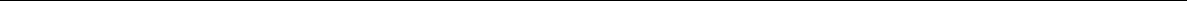
Fig. 2 IFT proteins are required for the timely relocalization of the kinase Aurora B to the central spindle. a Flag immunoprecipitation performed on mitotic HeLa Kyoto cells transfected with Flag and Myc or with Flag-IFT27 and Myc-Aurora B. b Myc immunoprecipitation performed on mitotic HeLa Kyoto cells transfected with Myc or with Myc-Aurora B. c PLA between Aurora B and IFT88 on anaphase LLC-PK1. Cells depleted in IFT88, negative control. Controls for IFT88 or Aurora B alone are provided in Fig 1a and Supplementary Fig. 4c, respectively. Maximum projections are shown. Magni fi cation, right: single confocal section of the dashed boxed area at the central spindle. d Immuno fl uorescence (left) showing α -tubulin or Aurora B staining in LLC-PK1 cells. Line scans (right) indicate whether Aurora B is accumulated at the central spindle or diffusely localized. Aurora B and DAPI fl uorescence intensities are measured from 1 to 2 along the yellow line. e Percentage of anaphase cells with Aurora B mislocalization. n > 50 anaphase cells. 3 experiments. Mean + / − s.d. ns: not signi fi cant compared to non-treated (NT) condition; ** P < 0.01 and *** P < 0.001 compared to non-treated and control ( t test). f Schematics: upon monopolar cytokinesis, cells polarize, reorganize their MTs (green) and cytokinetic regulators (red) are recruited to the most polarized area of the cell. STLC: kinesin-5 inhibitor S-trityl-l-cysteine. RO3306: Cdk1 inhibitor. g Western blots showing IFT88 depletion in LLC-PK1 cells treated or not with STLC then released or not in RO3306 for 10 min. α -tubulin: loading control. h Immuno fl uorescence images (left) showing Aurora B staining (red) in LLC- PK1 cells undergoing monopolar cytokinesis. α -tubulin (green) and DAPI (blue) are used to monitor cell polarization. Line scans (right) indicate whether Aurora B is well polarized or delayed. Fluorescence intensities are measured as in ( d ). i Percentage of polarized LLC-PK1 cells presenting a delay in Aurora B relocalization. n > 150 cells. Three experiments. Mean + / − s.d. ***, P < 0.001 compared to control ( t test). j Western blots (upper panel) showing AID- YFP-IFT88 depletion in HCT116 cells upon Auxin treatment (1 h). Percentage (lower panel) of polarized cells (STLC+ RO3306 30 min) presenting a delay in Aurora B relocalization. n > 100 cells. Three experiments. Mean+ / − s.e.m. *, P < 0.05 compared to control ( − ) ( t test). Scale bars: 10 μ m for main images, 3 μ m for